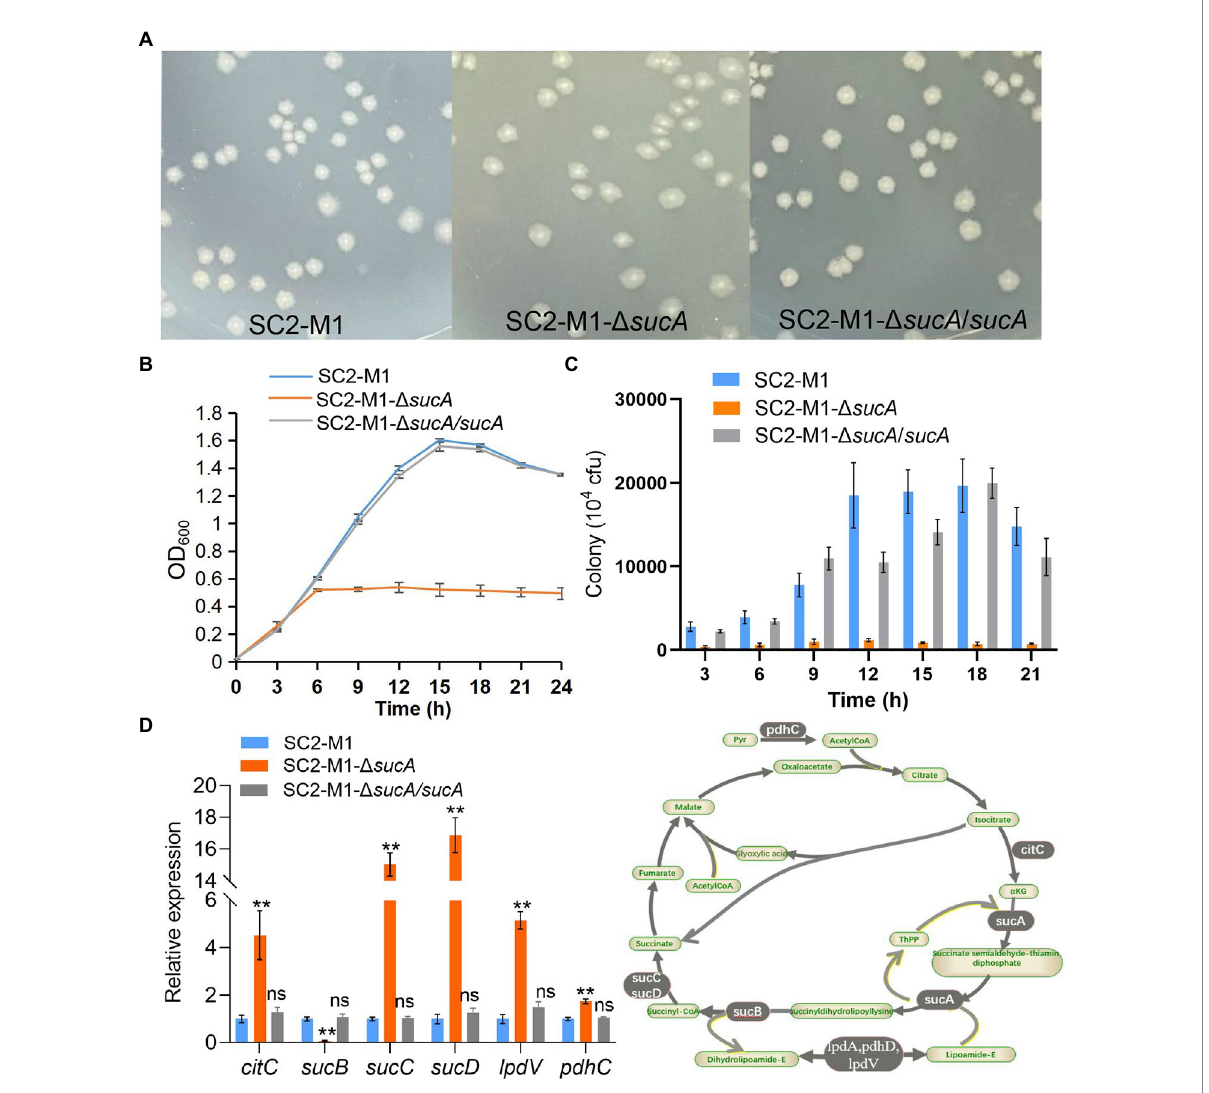
FIGURE 5 MsmR1 regulates carbohydrate metabolism by directly binding to the sucA promoter. (A) Colony morphology of the SC2-M1, SC2-M1- Δ sucA , and SC2-M1- Δ sucA / sucA strains in LB plates. (B) Growth curves of SC2-M1, SC2-M1- Δ sucA , and SC2-M1- Δ sucA / sucA in LB broth determined by OD 600 . (C) SC2-M1, SC2-M1- Δ sucA , and SC2-M1- Δ sucA / sucA colonies in LB broth determined by the live bacterial count method every 3 h. (D) Relative expression of genes related to the TCA cycle determined by qRT-PCR assay. ** p < 0.01 and ns, p >